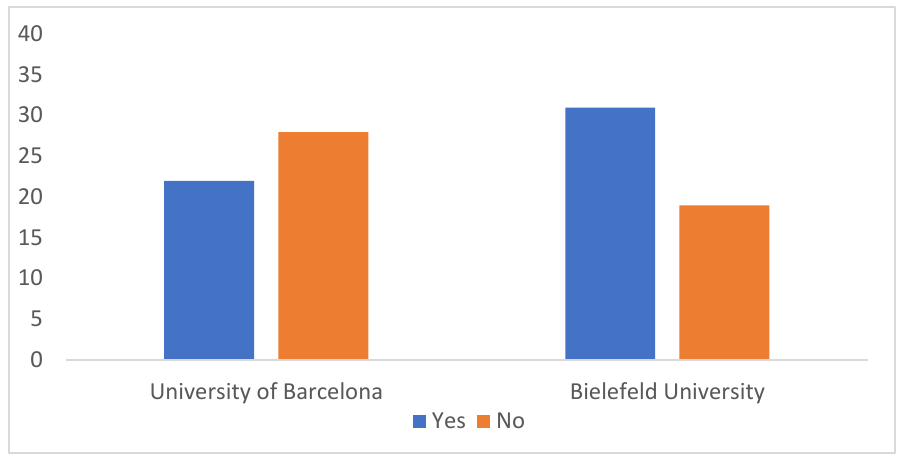
Figure 12. Ratio of subscribed and not subscribed respondents. In order to be able to choose which social media to use for the analysis of the digital environment, the respondents were asked to indicate to which social media they are subscribed and, in both cases, around 70% of respondents answered “Instagram” (see Figure 13). Therefore, the official account of the University of Barcelona @unibarcelona and the official account of Bielefeld University @bielefelduniversity will be analyzed as a part of the digital